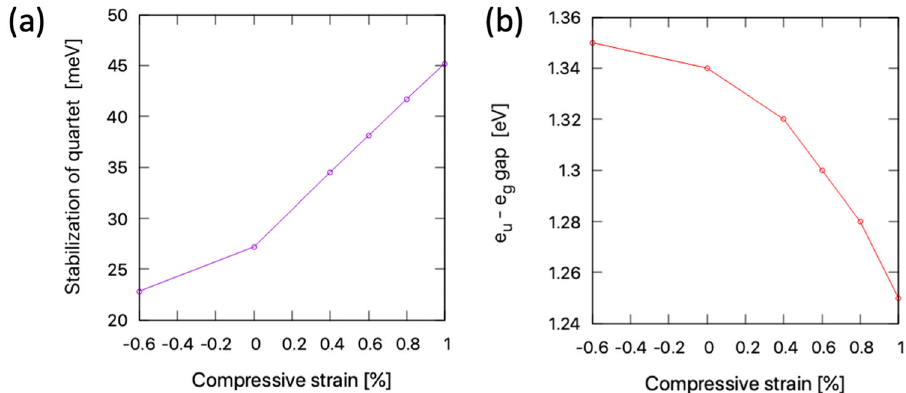
Fig. 2 Modi fi cations of the electronic structure due to the applied strain. a Stabilization of the quartet ground state over doublet as a function of applied compressive strain, computed at the HSE06 adiabatic potential energy surfaces, including the relaxation effects, together with b the respective modi fi cations of the e u – e g gap in the spin-up